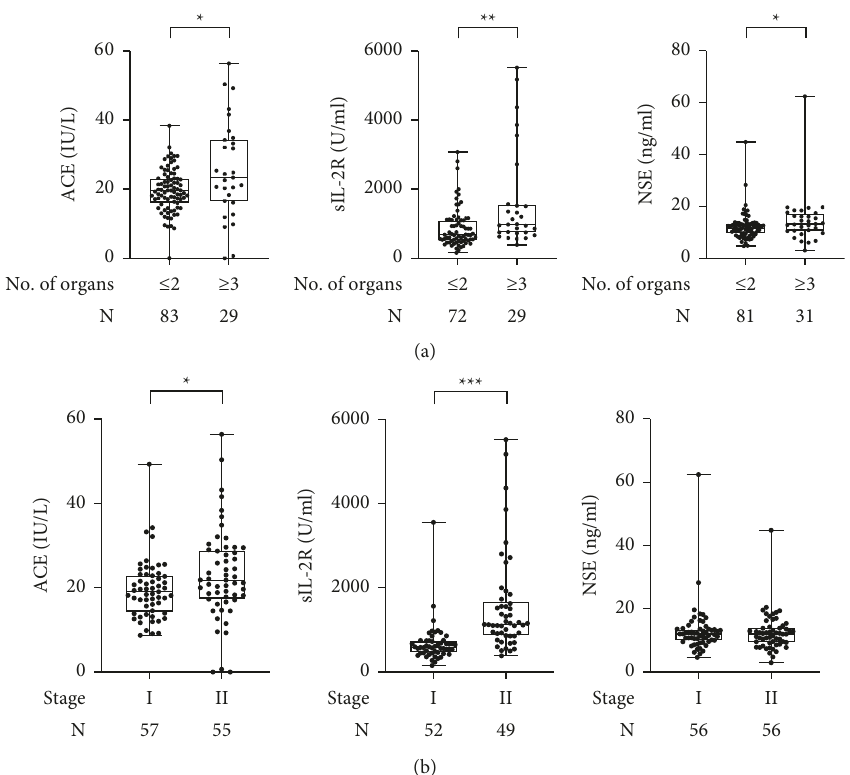
Figure 3: (a) Comparisons of the serum levels of NSE, sIL-2R, and ACE between sarcoidosis patients with ≤ 2 affected organs and those with ≥ 3 affected organs. (b) Comparisons of the serum levels of NSE, sIL-2R, and ACE between stage I sarcoidosis patients and stage II sarcoidosis patients. ∗ P < 0 . 05 ∗∗ P < 0 . 01; ∗∗∗ P < 0 . 001.